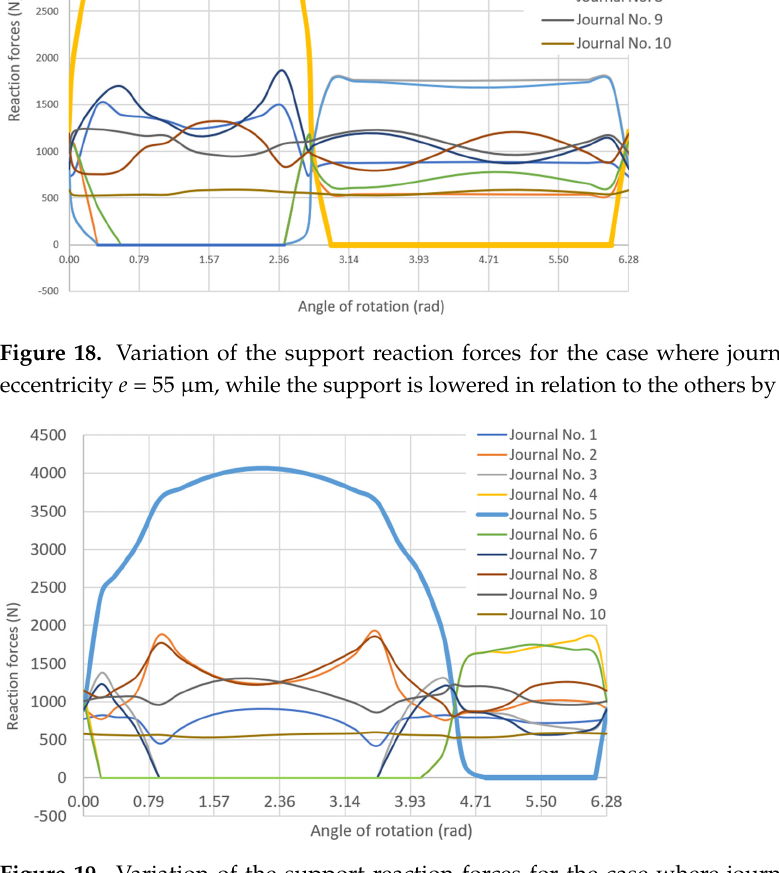
Figure 19. Variation of the support reaction forces for the case where journal No. 5 shows the eccentricity e = 25 µm while the support is lifted in relation to the others by x = 15 µm.